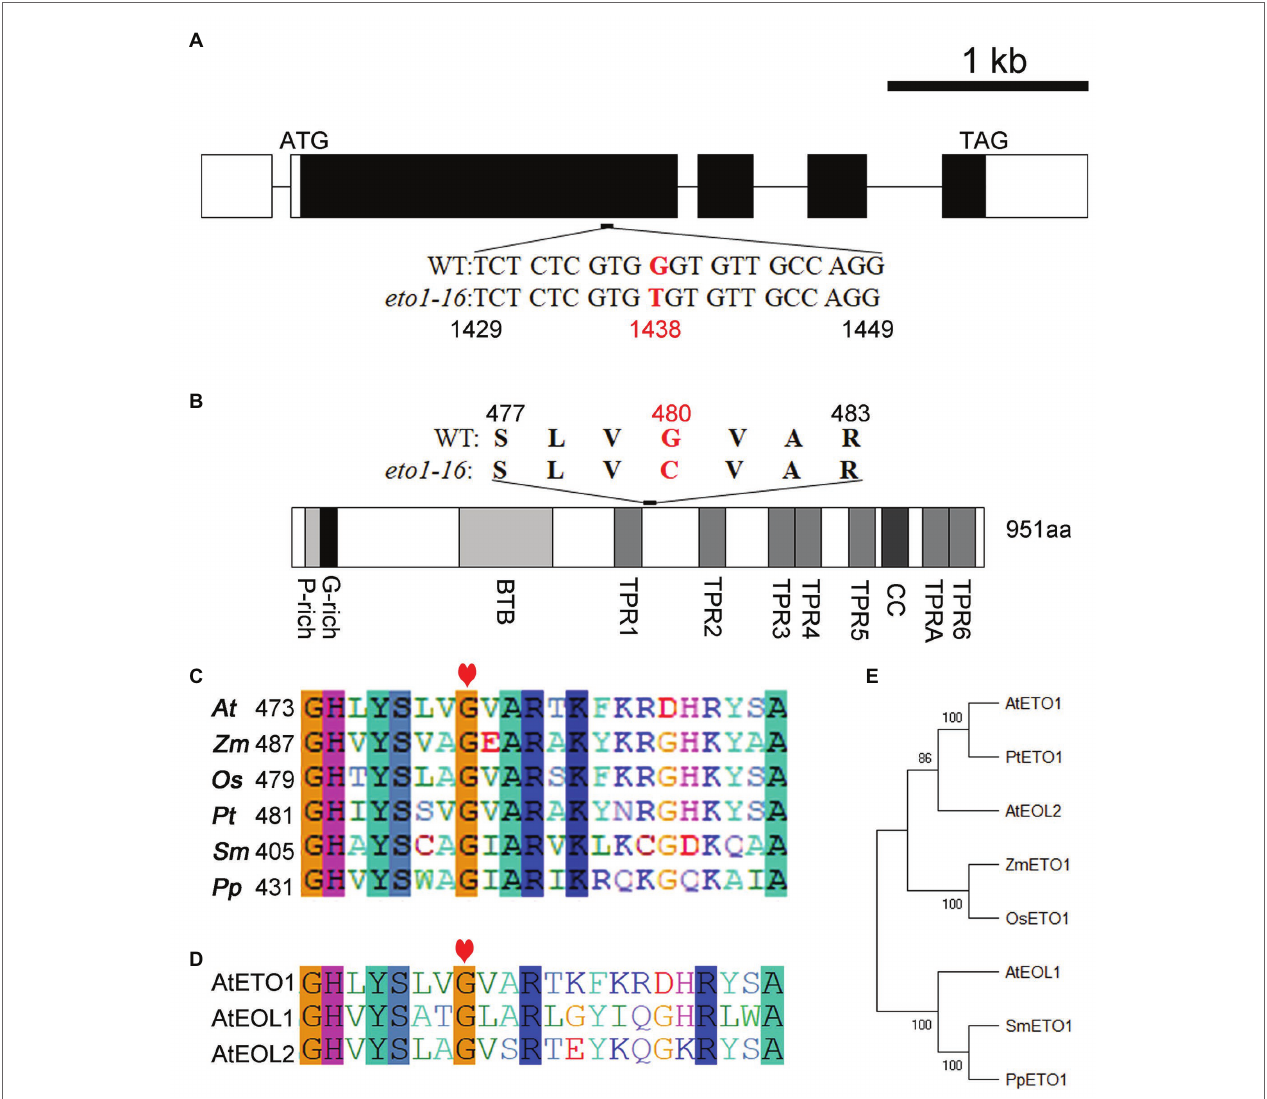
FIGURE 2 | Mutation analysis of eto1-16 and evolutionary analysis of ethylene overproduction 1 (ETO1). (A) Gene structure model of ETO1 . The white box represents the untranslated region (UTR); the black box represents the protein-coding region; the black line represents the introns. Below the gene structure model, the mutant base site of eto1-16 is shown, marked in red. (B) Protein domain structure of ETO1. Above the protein domain structure, the mutant amino acid site of eto1-16 is shown, marked in red. (C) Multiple sequence alignment of the region around the mutation site in eto1-16 . The red heart indicates the mutant position. (D) Protein sequence alignment of the region in (C) among ETO1, EOL1, and EOL2 in Arabidopsis . (E) Phylogenetic analysis of ETO1 among different species, including Arabidopsis thaliana (At) , Zea mays (Zm) , Oryza sativa (Os) , Populus tomentosa (Pt) , Selaginella moellendorffii (Sm) , and Physcomitrella patens (Pp)